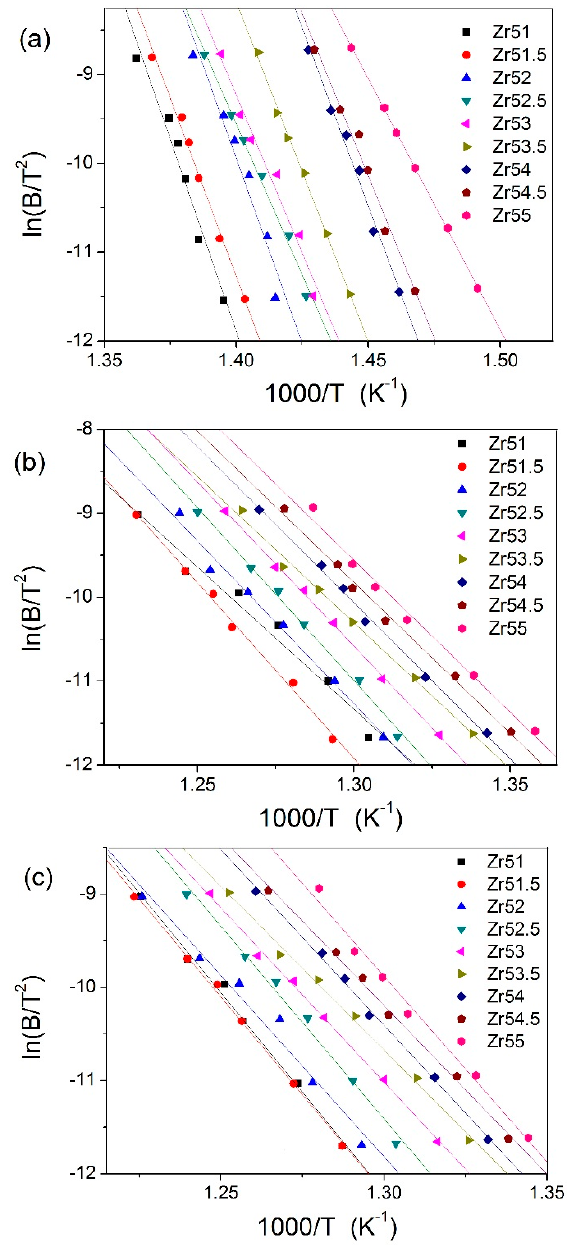
Figure 6. Kissinger plots for: T g ( a ); T x ( b ); and T p ( c ).